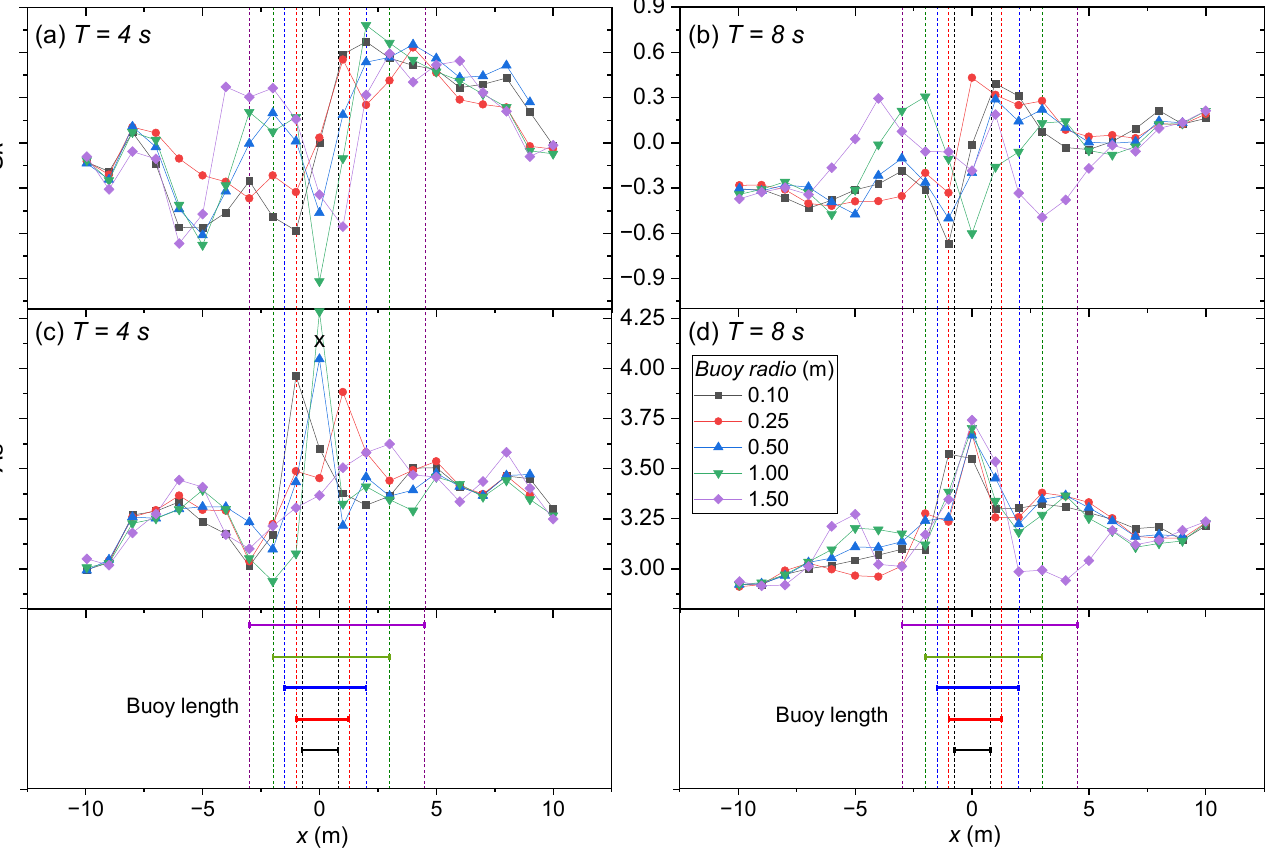
Figure 11. Skewness (horizontal asymmetry ( a , b ) and asymmetry velocity ( c , d )) evaluated with five buoys’ radii for T = 4 s and T = 8 s. The different colors represent different buoys’ sizes, as shown in the bottom panels. The vertical, dashed lines show the position of the buoy, with the different colors representing different buoys’ radii.